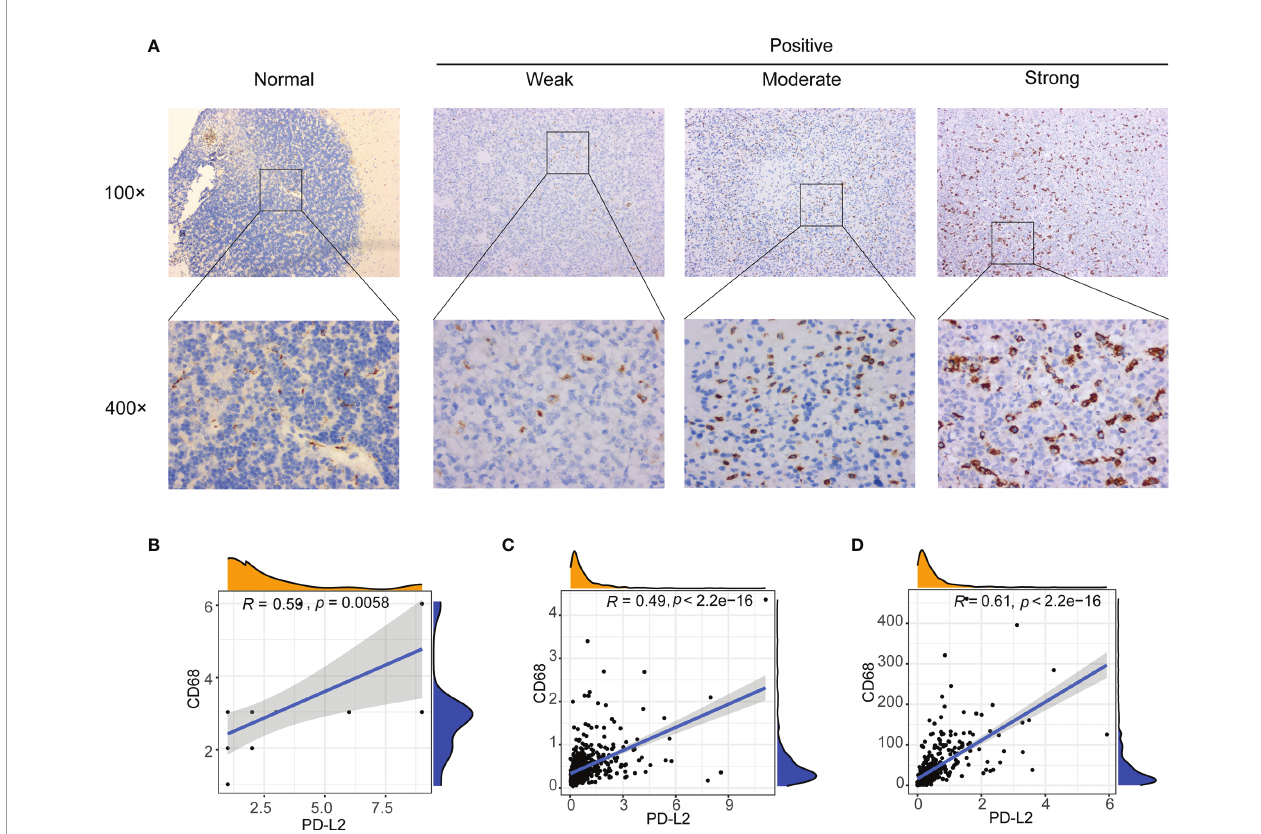
FIGURE 6 | Correlation between PD-L2 expression and macrophages marker (CD68 expression) in gliomas. (A) Representative images of immunohistochemical (IHC) staining of CD68 protein in glioma tissues and normal brain tissue (×100 and ×400). (B – D) PD-L2 expression was signi fi cantly associated with macrophages marker (CD68 expression) in glioma specimens (B) , TCGA database (C) , and CGGA database (D)